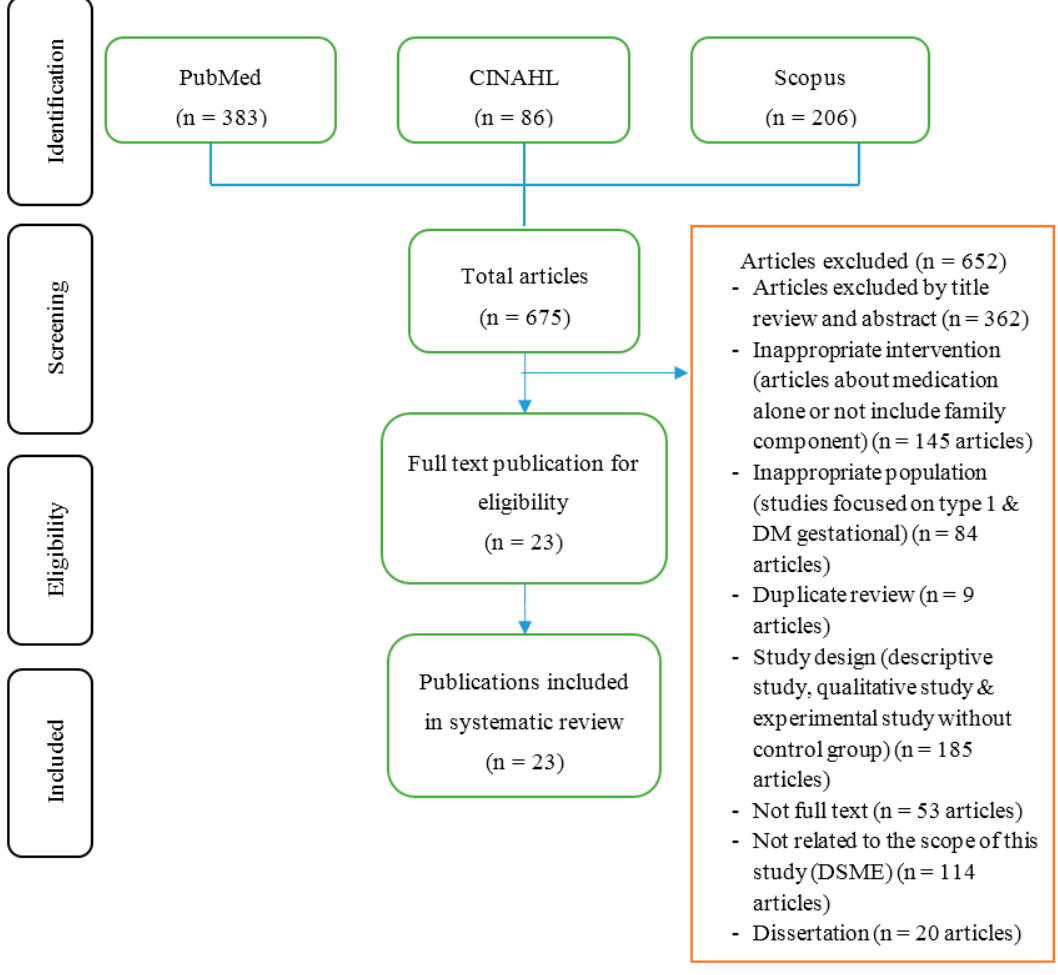
Figure 1. Summary of evidence search and selection.